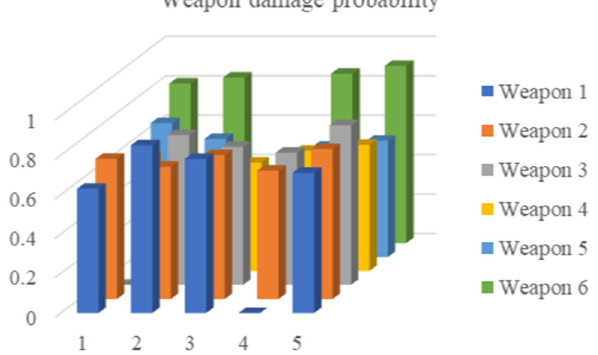
Fig. 4 The histogram of the weapon damage probability for case 2